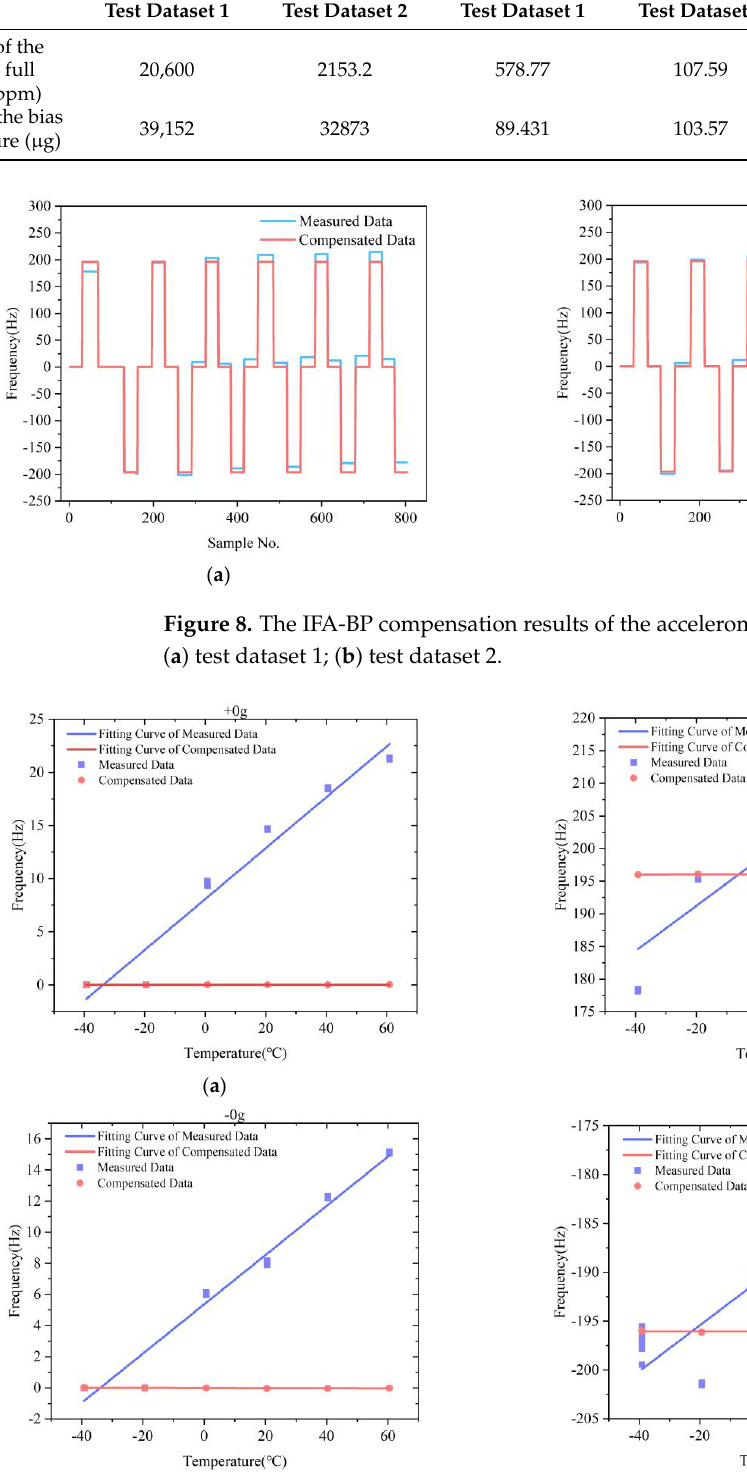
( d ) Figure 10. The IFA-BP compensation results of test dataset 2 in the full-temperature experiment: ( a ) +0 g; ( b ) +1 g; ( c ) −0 g; ( d ) −1 g. 4. Conclusions